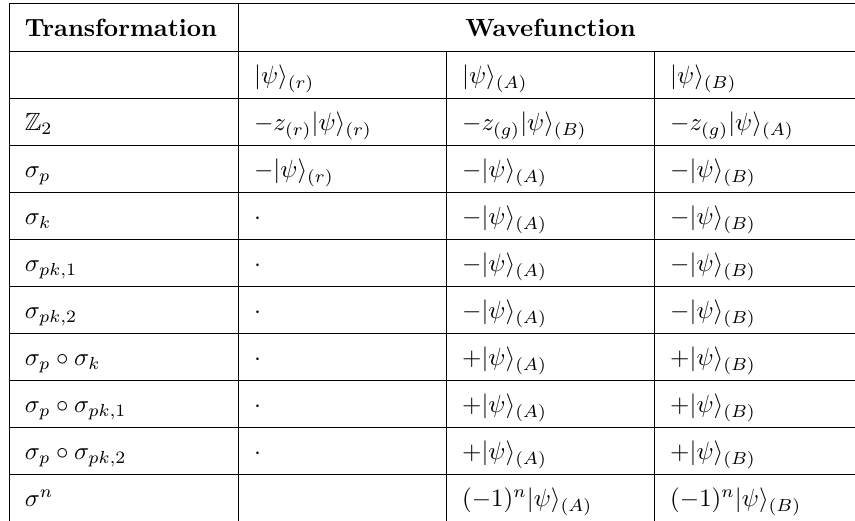
Table 1 . A summary of the transformations of the wavefunctions considered in the text under the discrete symmetries of the problem. Here | ψ i solutions are as given in (5.41) with the coefficients in (5.46), (5.47) respectively. The respective Z eigenvalues are z 2 momentum maps are as defined in (5.70). ( σ n means any n -composition of the sigma operators). (with the map σ